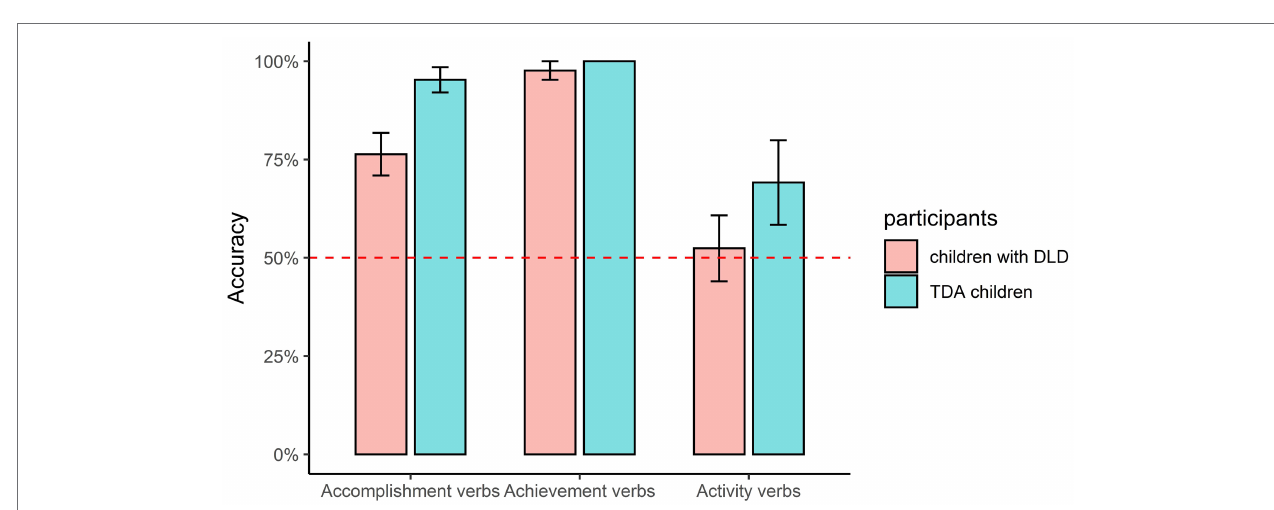
FIGURE 4 | Accuracy of - le being combined with different types of